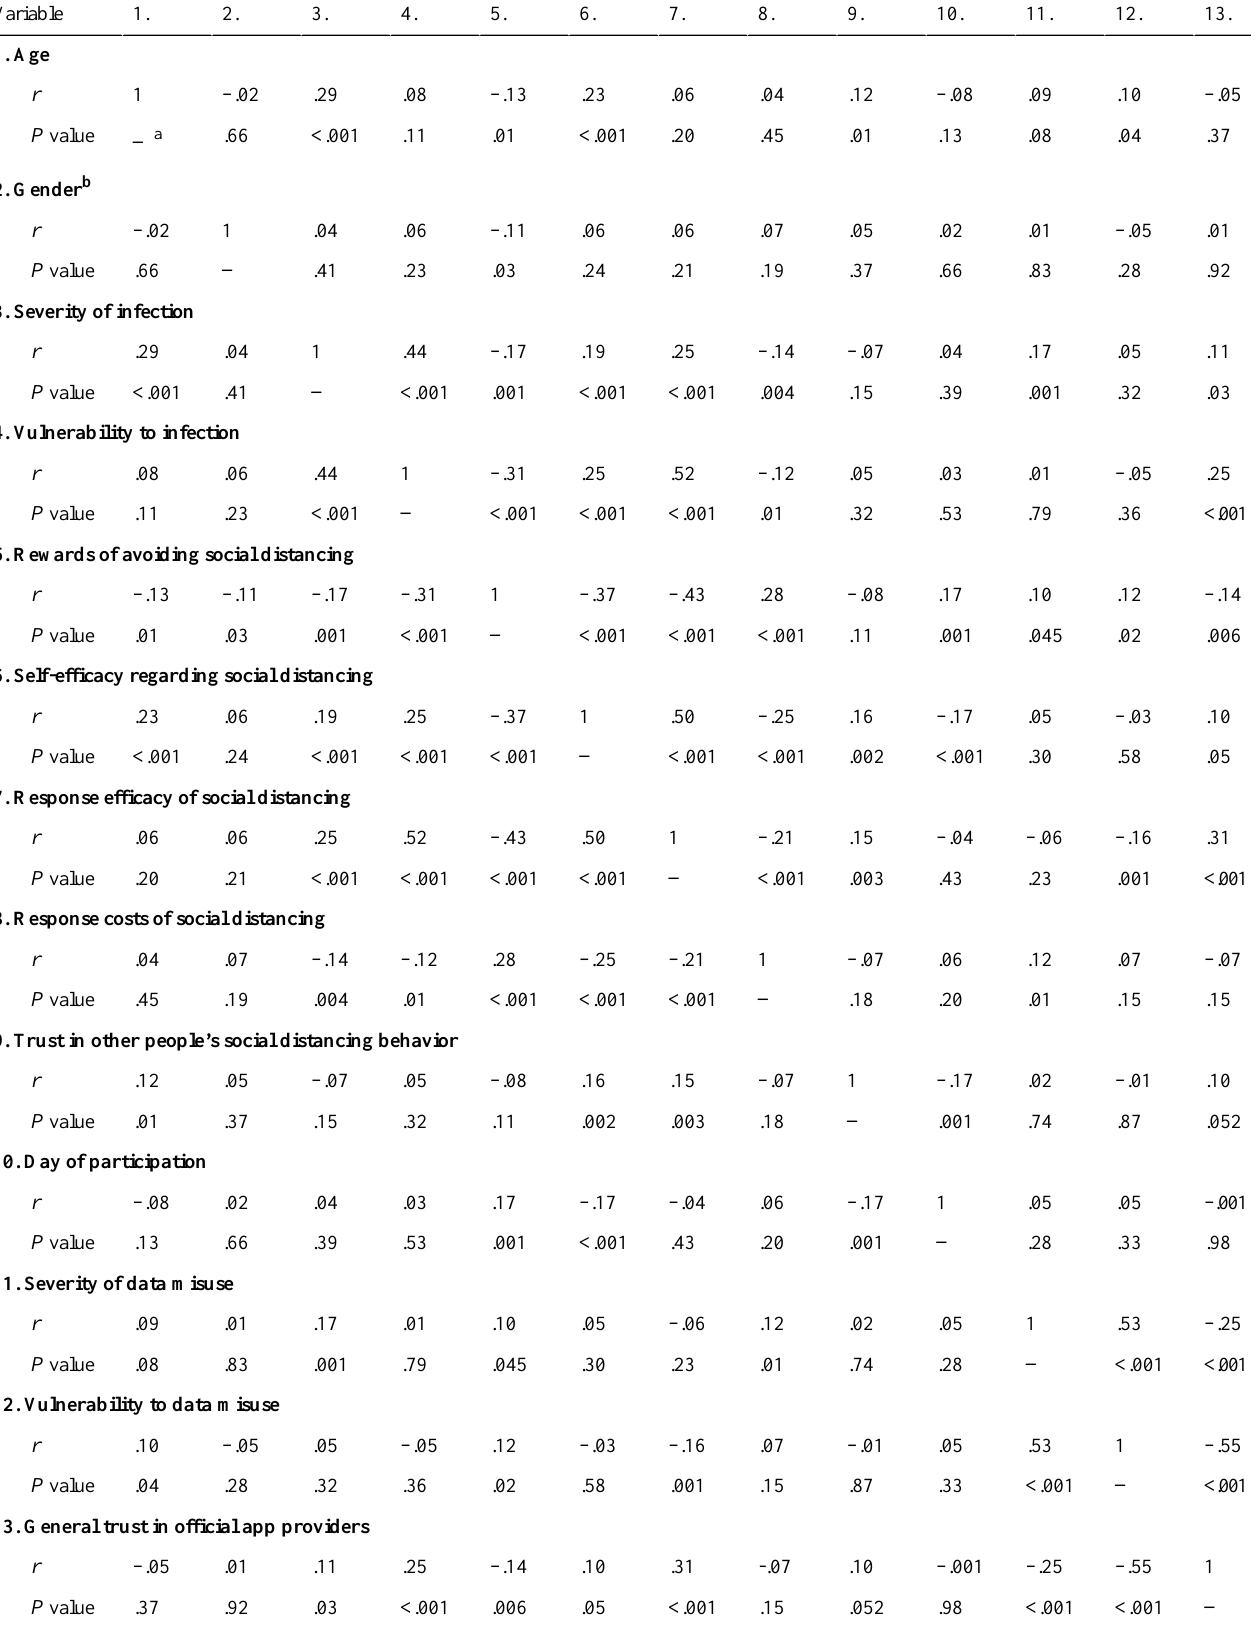
Table 1. Bivariate correlations (Pearson r and two-tailed P value) among all independent variables of the regression